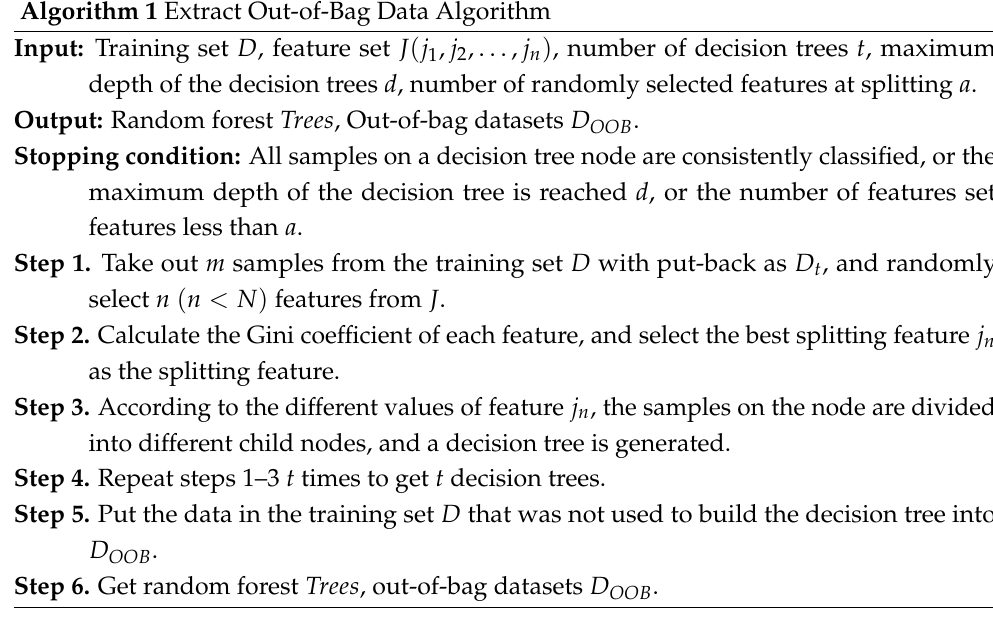
Algorithm 2 is a feature weight solving and selection algorithm using out-of-bag estimation. The out-of-bag estimation under differential privacy is used to solve feature weights and decision tree weights, select feature weights, and update the features set. Algorithm 2 Solving Feature Weights and Selecting Algorithms Using Out-of-Bag